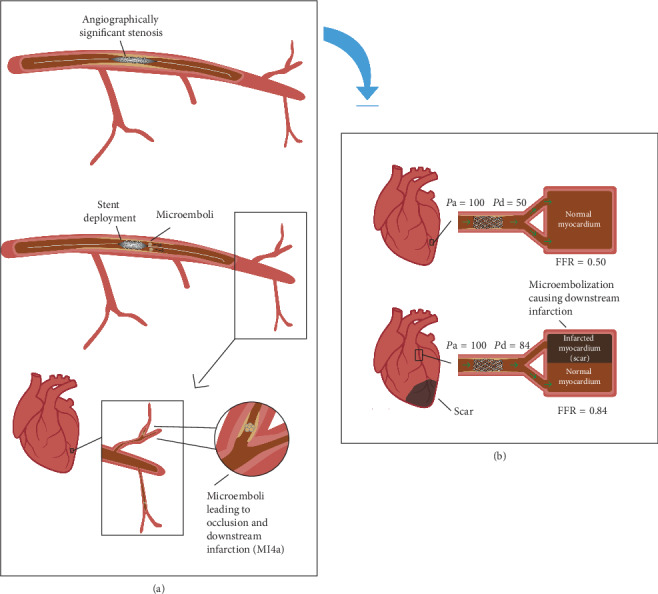
Illustration of falsely elevated FFR value in the setting of MI4a: (a) Depiction of downstream infarction due to MI4a. FFR calculation through a patient with a normal heart and no evidence of downstream flow limitation. (b) Falsely elevated FFR values may result secondary to MI4a. A falsely elevated FFR value in the setting of MI4A. MI4a limits the maximal achievable hyperemic flow and hence leads to a falsely elevated FFR value.